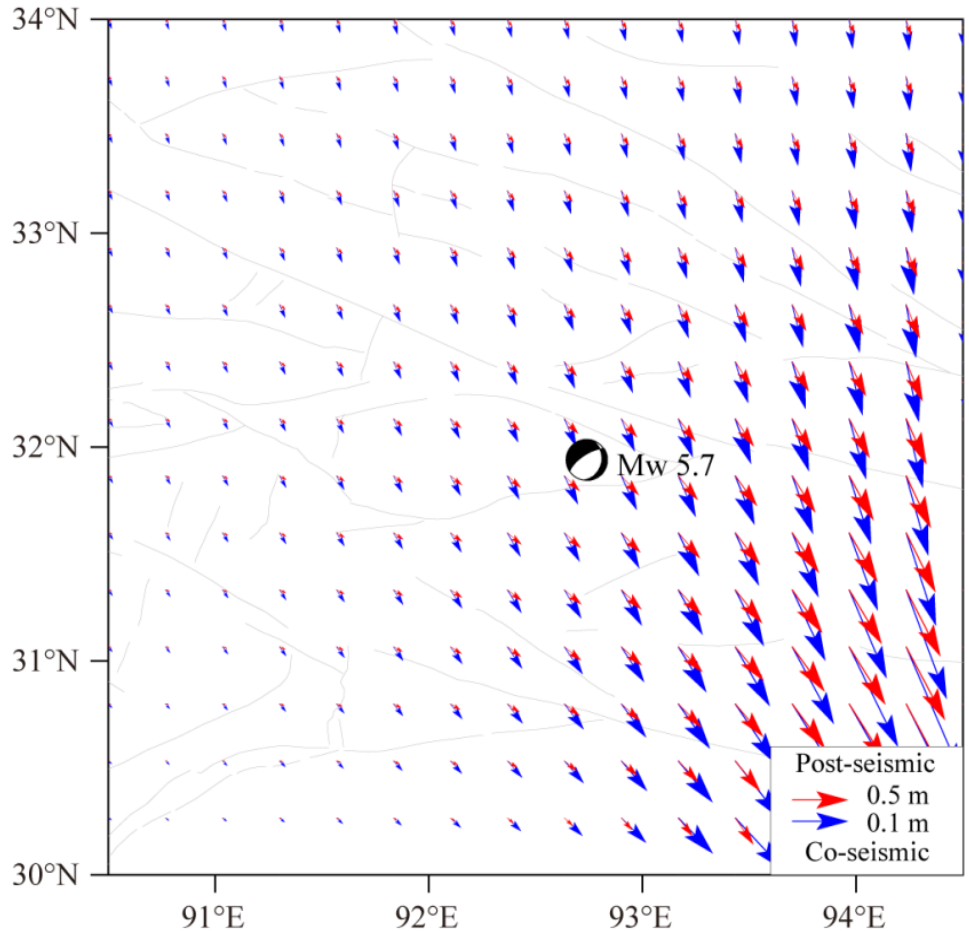
Figure 7. Co- and post-seismic displacement fields associated with the Assam earthquake. The blue and red arrows indicate the displacement field generated by the co- and post-seismic effects of the Assam earthquake, respectively.